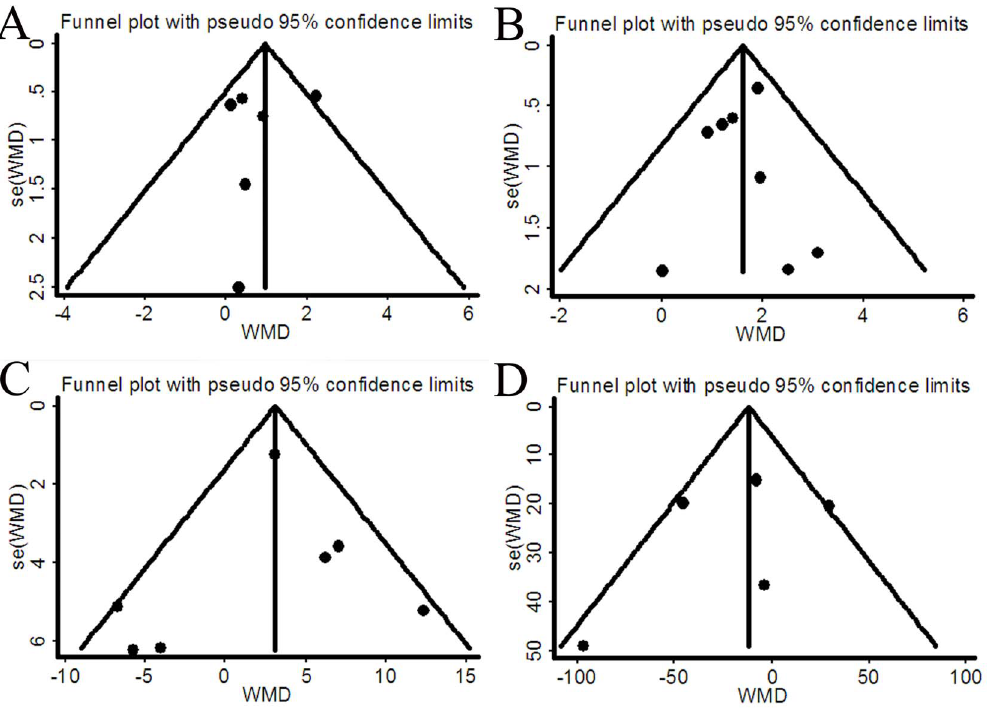
Figure 3. Funnel plots demonstrating publication bias for body weight (A), fat-free mass (B), maximal inspiratory pressure (C) and six-min walk distance (D).